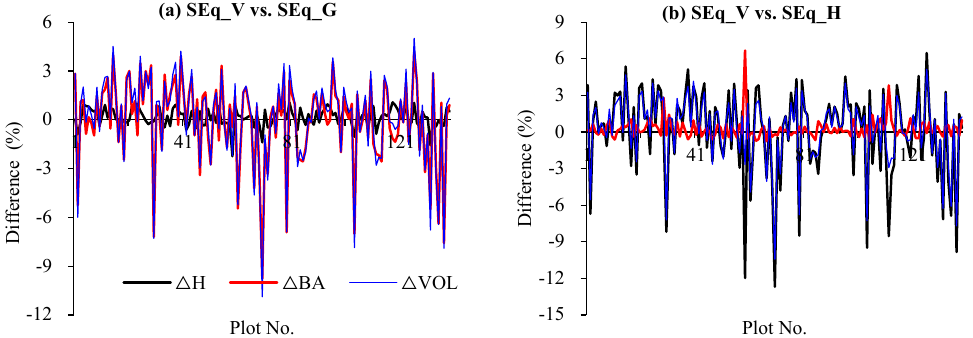
Figure 2. The plot-level differences in the estimates of H, G, and V between the simultaneous equations of the fir forest: ( a ) SEq_V vs. SEq_G, ( b ) SEq_V vs. SEq_H.